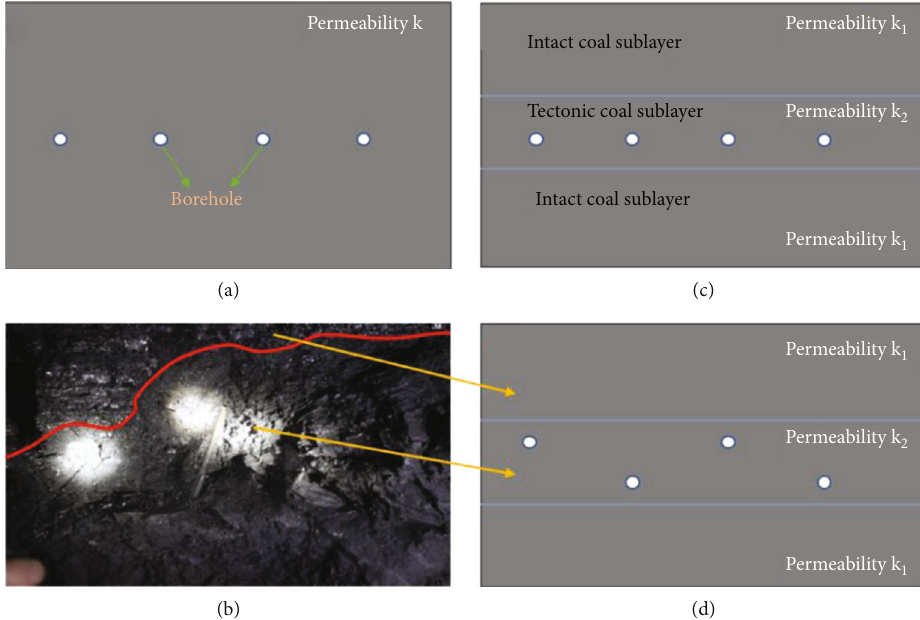
Figure 1: Schematic diagram of coal seam borehole layout: (a) traditional bedding boreholes in a single coal seam; (b) intact and tectonic coal sublayers; (c) bedding boreholes in combined coal seams; (d) adjusted bedding boreholes in combined coal